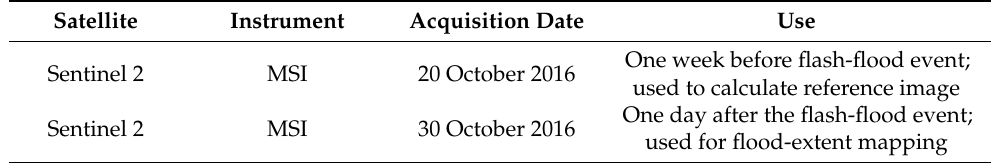
Table 1. Data images used in this study.